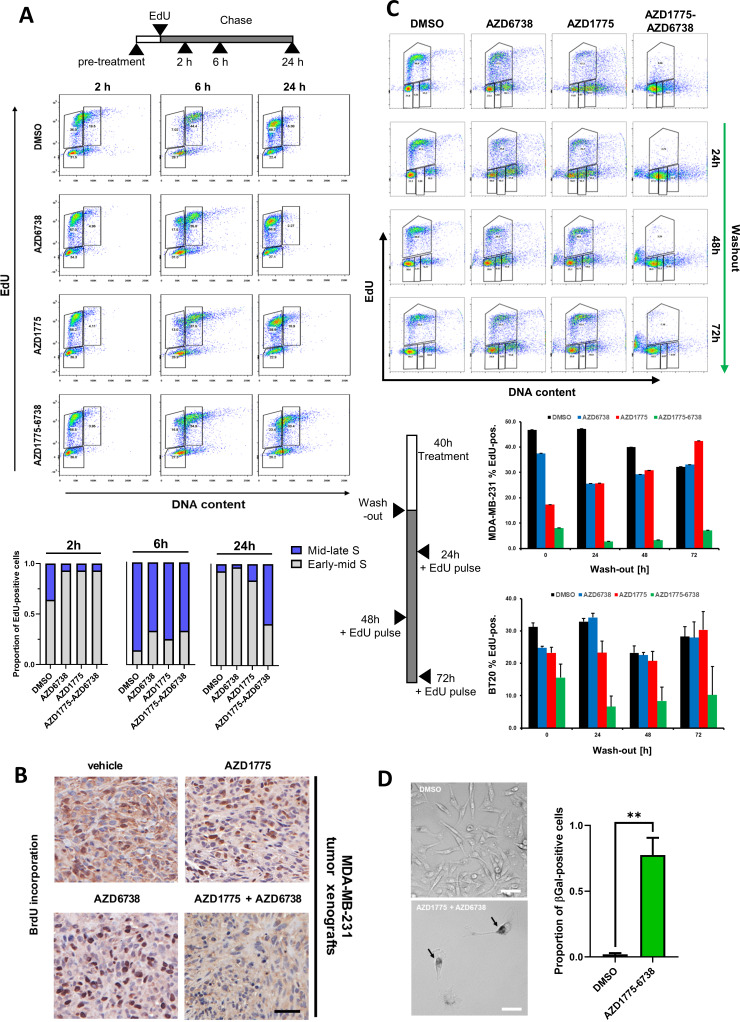
ATR inhibition by AZD6738 exacerbates AZD1775-induced RS and abrogates recovery of replication.(A) MDA-MB-231 cells were pre-treated with AZD1775 (500 nM), AZD6738 (1 µM) or their combination, pulse-labelled for 30 min with EdU, and chased for the times indicated. DNA content and EdU-intensity were assessed by flow cytometry at 2, 6 and 24 hr to visualize replication for the different treatments. Upper panel: representative FACS plots. Y- and X-axes represent EdU and DNA content (propidium iodide), respectively. Bottom panel: Graphs representing proportion of EdU-positive mid-late S (blue) versus early-mid S DNA content (gray). (B) BrdU incorporation in tumour tissues. Mice bearing MDA-MB-231 tumours and treated with AZD1775, AZD6738, AZD1775+AZD6738 combination or vehicle control received an i.p. injection of BrdU 1 hr before termination. Formalin-fixed paraffin-embedded tumour tissue was analysed by IHC for detection of incorporated BrdU. Brown nuclear staining defines positive cells. Representative images are shown. Scale bar = 50 μM. (C) Representative cell cycle plots of MDA-MB-231 and BT20 cells labelled by EdU-PI and analysed by flow cytometry after 40 hr drug treatment following drug washout for the indicated times. Before fixing at the respective time points, cells were pulsed with EdU for 30 min to assess actively replicating cells. Upper panel: Representative FACS plots for the indicated time points and treatments in MDA-MB-231 cells; Bottom panel: Quantification of percentage of cell population in active S-phase (EdU+) from two independent experiments in MDA-MB-231 and BT20 cells, respectively (± SEM). (D) Senescence associated-β-Galactosidase staining following 72 hr of AZD1775-AZD6738 combination treatment (500 nM AZD1775 and 1 μM AZD6738) and 5 days drug wash-out. Left: Representative images of DMSO and AZD1775-AZD6738 combination-treated cells. Right: Bars indicate mean proportion of β-Galactosidase-positive cells and (± SEM) of four replicates. ** denotes p=0.001 as assessed by Student’s t-test. Scale bar = 20 μM.